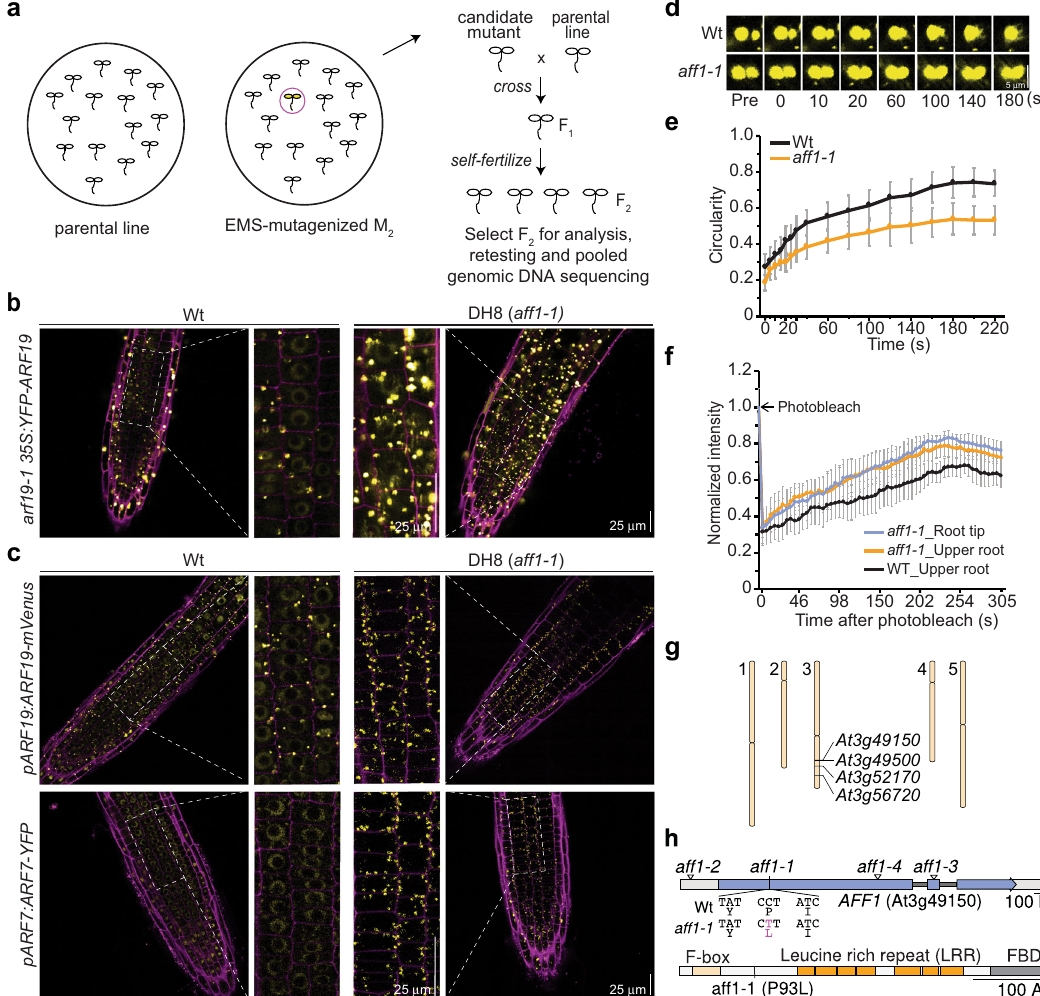
Fig. 1 Identi fi cation At3g49150 / AFF1 for ARF19 hypercondensation. a EMS-mutagenized M 2 seeds of arf19-1 35 S:YFP-ARF19 were screened for individuals with increased numbers of YFP-ARF19 condensates using a fl uorescence dissecting microscope. Isolate DH8 was backcrossed to the parental line ( arf19-1 35 S:YFP-ARF19 ) and the resultant F 2 individuals displaying YFP-ARF19 hypercondensation identi fi ed and used for whole-genome sequencing of bulk segregants. b Confocal images of 3d-old Wt (Col-0) and DH8 ( aff1-1 ) seedlings carrying 35 S:YFP-ARF19 (false-colored yellow) with cell walls counterstained with propidium iodide (false-colored magenta). Scale bar = 25 µ m. c Confocal images of 3d-old wild type (Wt; Col-0) and aff1-1 seedlings carrying pARF19:ARF19-mVenus , or pARF7:ARF7-YFP (false-colored yellow) with cell walls counterstained with propidium iodide (false-colored magenta). Scale bar = 25 µ m. d Time course confocal images showing fusion of condensates in root transition zone cells of 3d-old Wt (Col-0) and aff1-1 seedlings carrying UBQ10:YFP-ARF19 . Scale bar = 5 µ m. e Condensate circularity measurements after condensate fusion events in 3d-old Wt (Col-0) and aff1-1